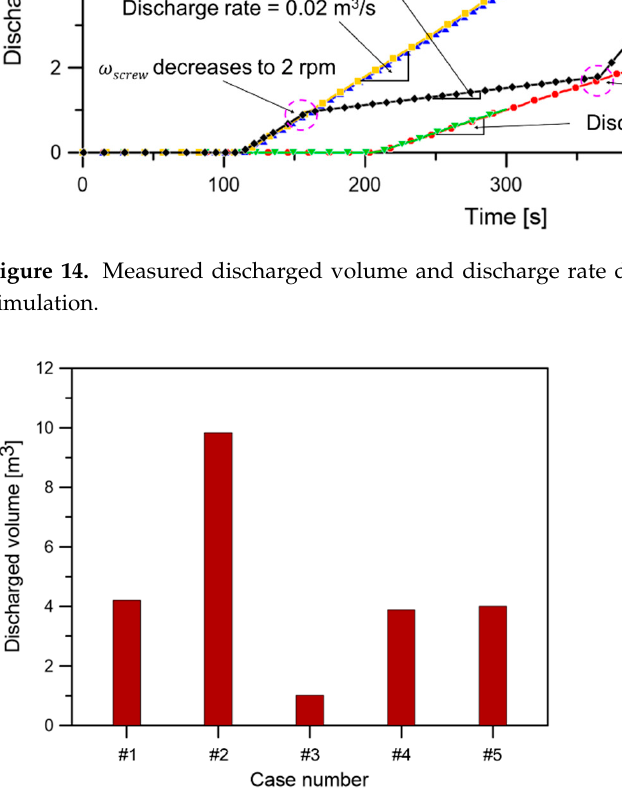
Figure 16. Comparison of surface settlement after the EPB shield has advanced 300 mm: ( a ) trans- verse settlement trough; ( b ) longitudinal settlement trough. 4. Conclusions A coupled DEM–FDM numerical model simulated EPB shield tunnelling. Its main components are an actual-size spoke-type EPB shield and ground formation. Modeling used large-scale triaxial test analyses for calibration and a two-step ground formulation scheme with DEM–FDM coupling. Subsequent tunnelling simulations adopted varying penetration rate and rotational speed of the screw conveyor, including their automatic control during operation. Torque, thrust force, chamber pressure, discharge, and settle- ment data were obtained, and their implications were discussed. The conclusions of this numerical study are summarized as follows: 1. The numerical model successfully simulated EPB shield tunnelling under control of the operational conditions. During an advance of 300 mm, the penetration rate and rotational speed of the screw conveyor were varied four times in response to the